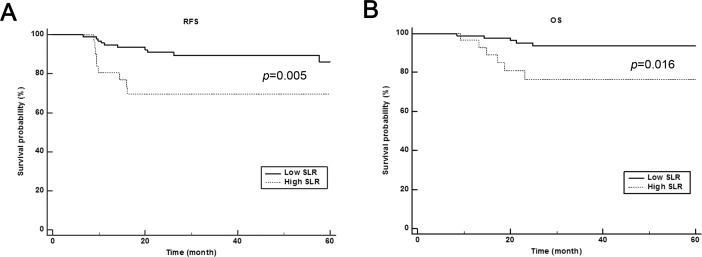
Cumulative recurrence-free survival (A) and overall survival (B) curves on the basis of spleen to liver ratio (SLR). Patients with high SLR showed significantly worse prognosis than those with low SLR values.